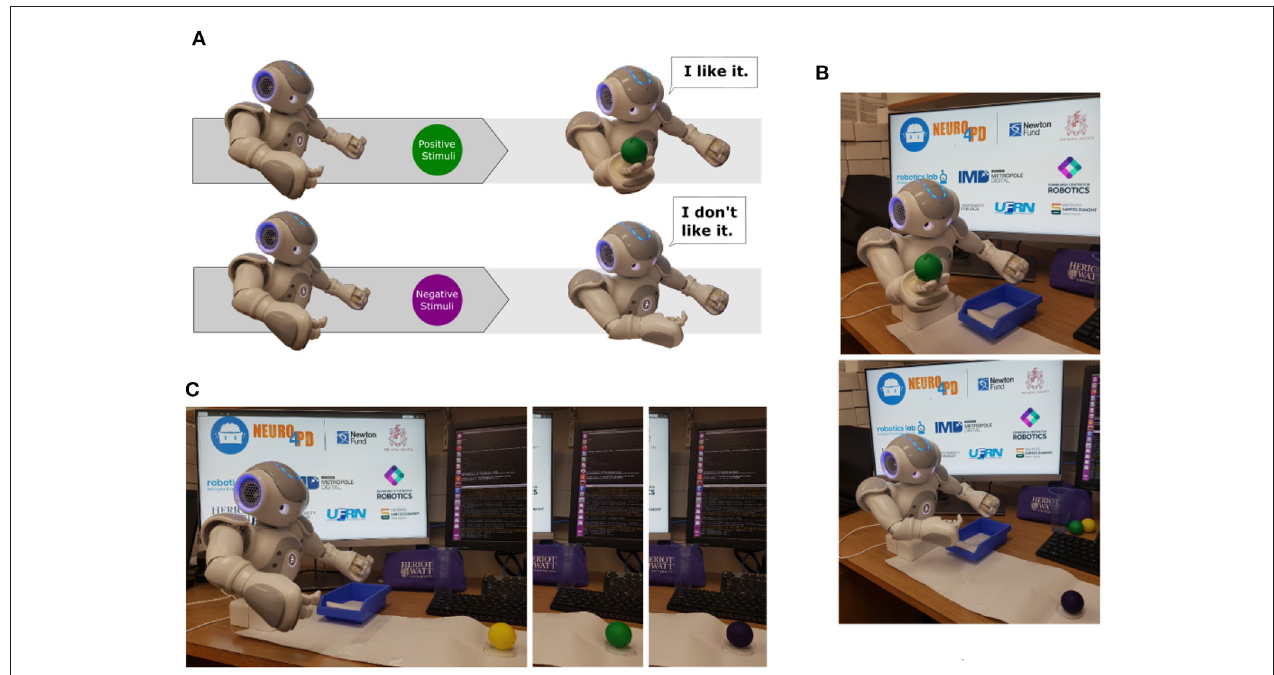
FIGURE 7 | In (A) , two different destination poses based on distinct visual stimulus. The first one, the robot senses the object as a positive stimulus. It then extends its right arm and opens its hand to grasp the object. The second one, the robot senses the object as a negative stimulus and moves its right arm closer to its torso similar to a rejection behaviour. (B) Shows behavioural responses based on visual information. On the top image, the robot sensed a positive stimulus and activated the curiosity behaviour. On the bottom image, the robot sensed a negative stimulus and initiated the rejection behaviour. In (C) , the composed image presents the stage of the task when the robot senses each ball based on its colour: yellow, green, and